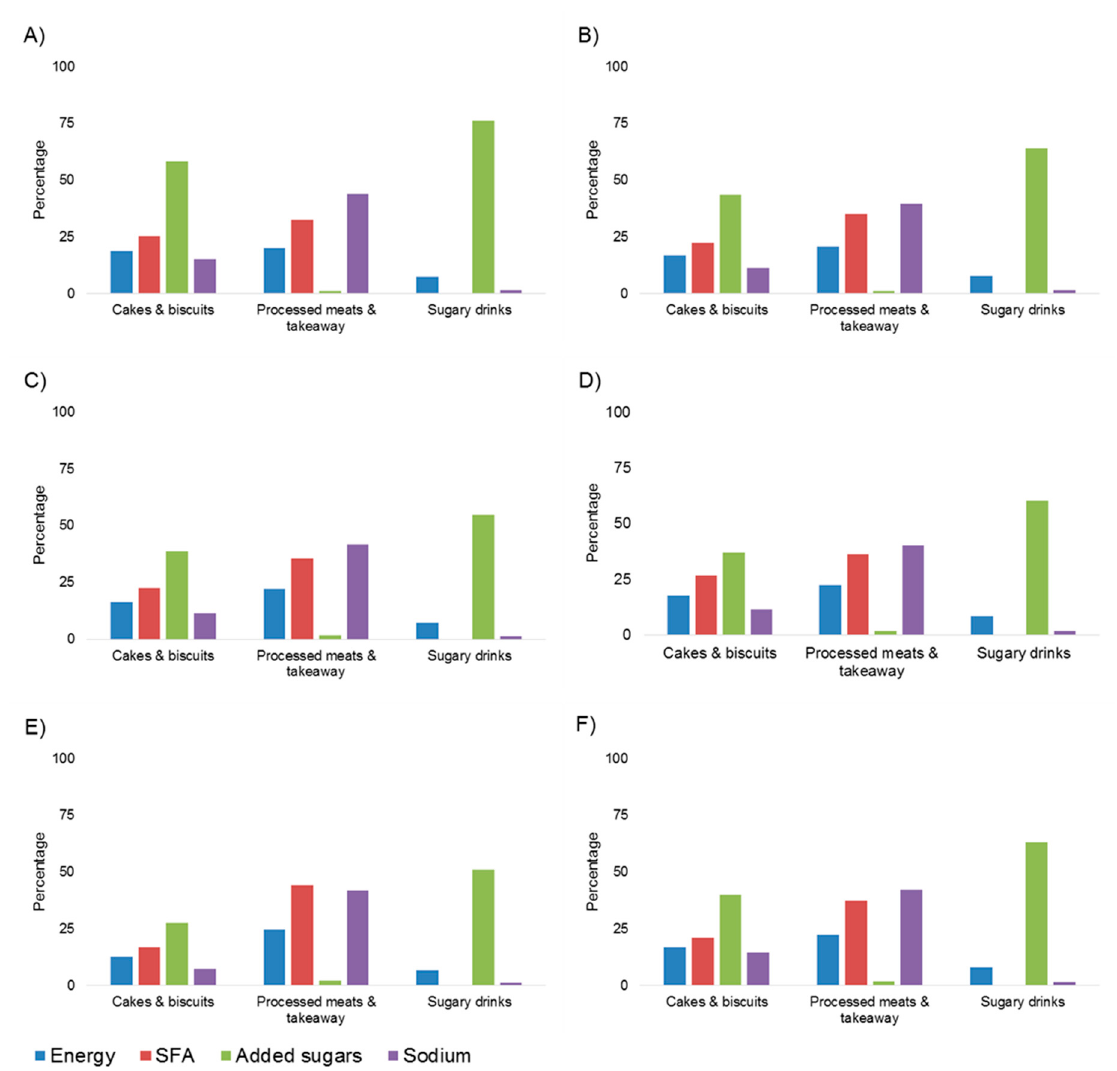
Figure 1. Target discretionary choice subgroups contribution to total percentage energy, SFA, added sugars and sodium, by age group of consumers. Values presented as an average percentage for